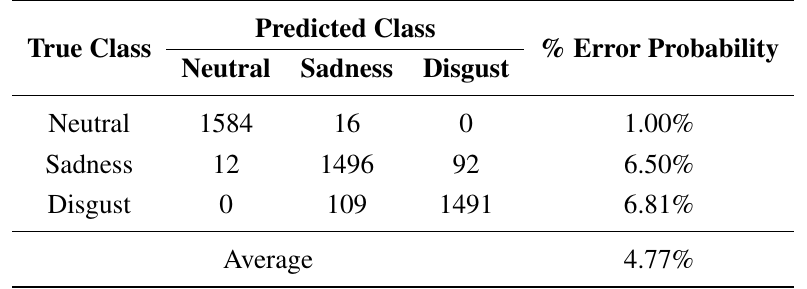
Table 4. Confusion matrix and percentage of classification error (error probability) for each class using a maximum number of 60,000 operations per second ( N particularized for Analysis 2: emotional state.